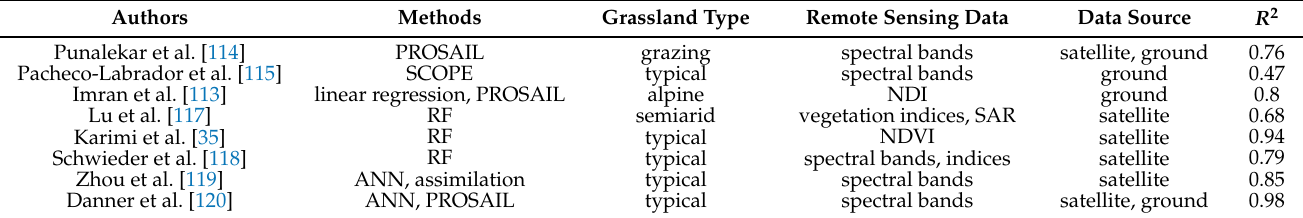
Table 5. Detailed information on the involved estimation studies for